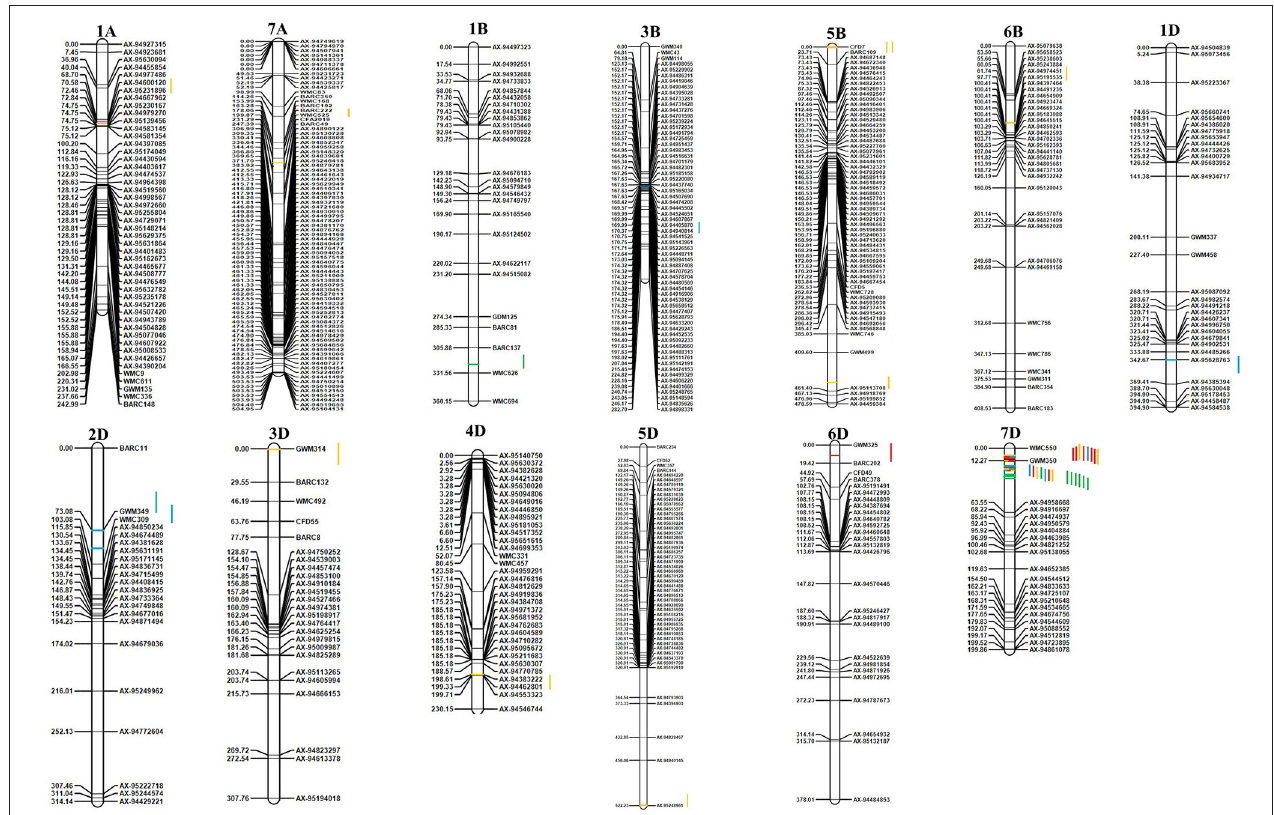
FIGURE 3 | Genetic linkage map and QTL positions identified in A, B, and D genomes of RILs derived from WH 542 × synthetic derivative cross. Red color indicates QTLs for GFeC; Blue color indicates QTLs for GZnC; Yellow color indicates QTLs for grain GPC; Green color indicates QTLs for TKW.